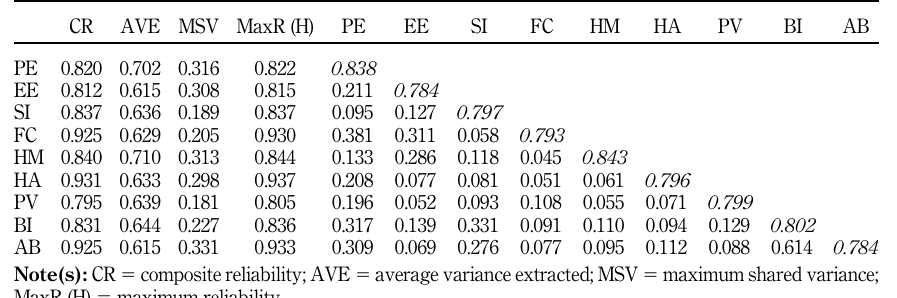
Table 4. Measurement model assessment using model fit indices